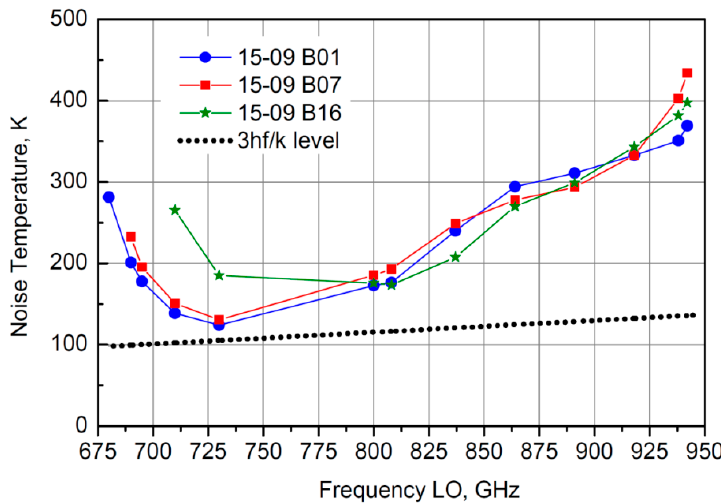
Figure 11. DSB noise temperature for three SIS mixers as a function of frequency; noise temperature was corrected for losses in the input window and beam splitter. The dotted line shows the noise temperature, which corresponds to 3 hf/k B .